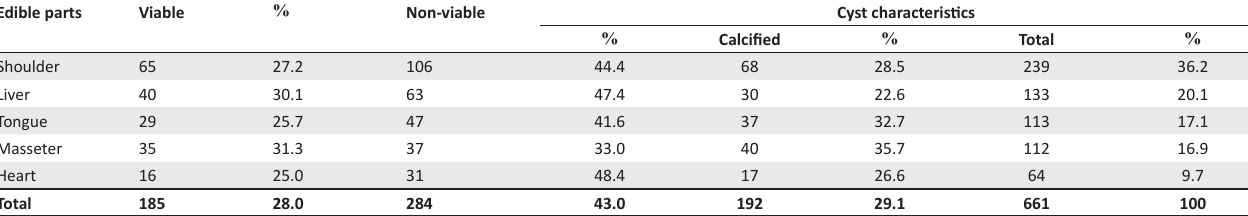
TABLE 4: Characterisation of cysticerci of Taenia saginata collected from edible parts of infected cattle. Edible parts Viable %